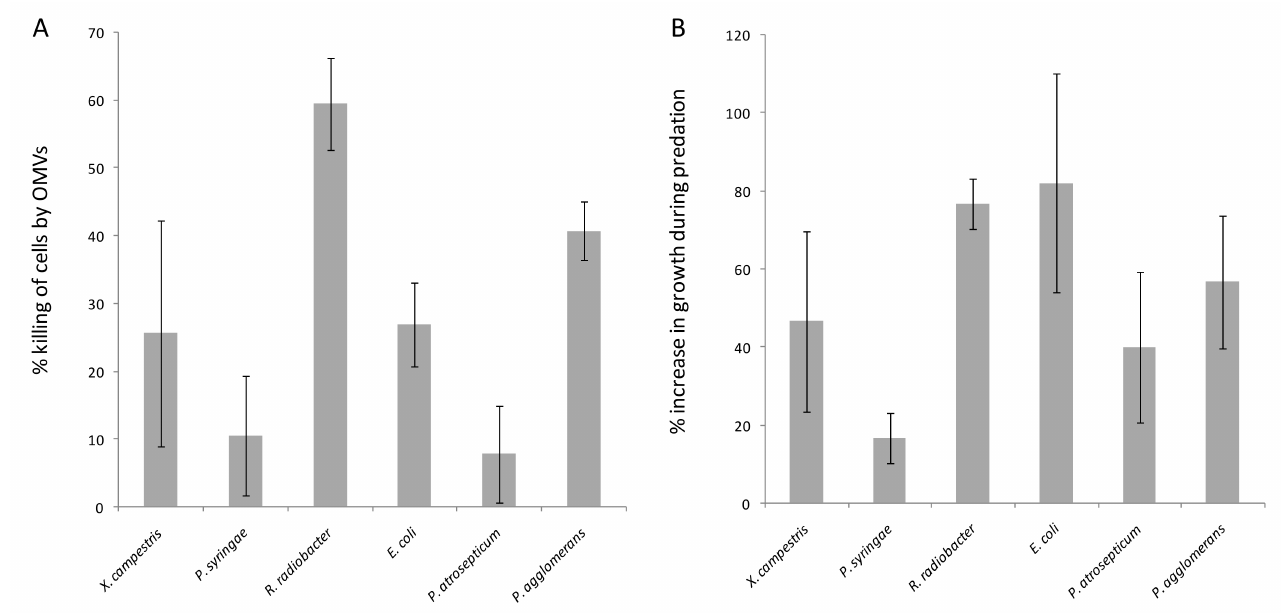
Figure 3. Predatory activity of isolated OMVs ( A ) and cells ( B ) of EH715. OMV killing is expressed as the % of prey cells killed by incubating with OMVs, while whole-cell killing is presented as the % increase in swarming growth when growing on prey (higher myxococcal growth means greater cellular predation). Error bars represent ± 1 standard deviation ( n ≥ 3). Prey organisms presented in the same order as Figure